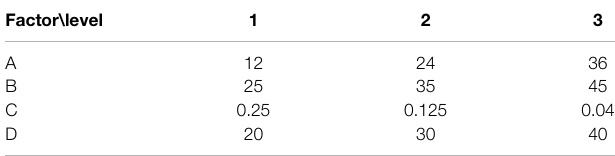
TABLE 1A | 1-FSMN orthogonal experiment table. TABLE 1B | Orthogonal experimental data of 1-FSMN branched molecule